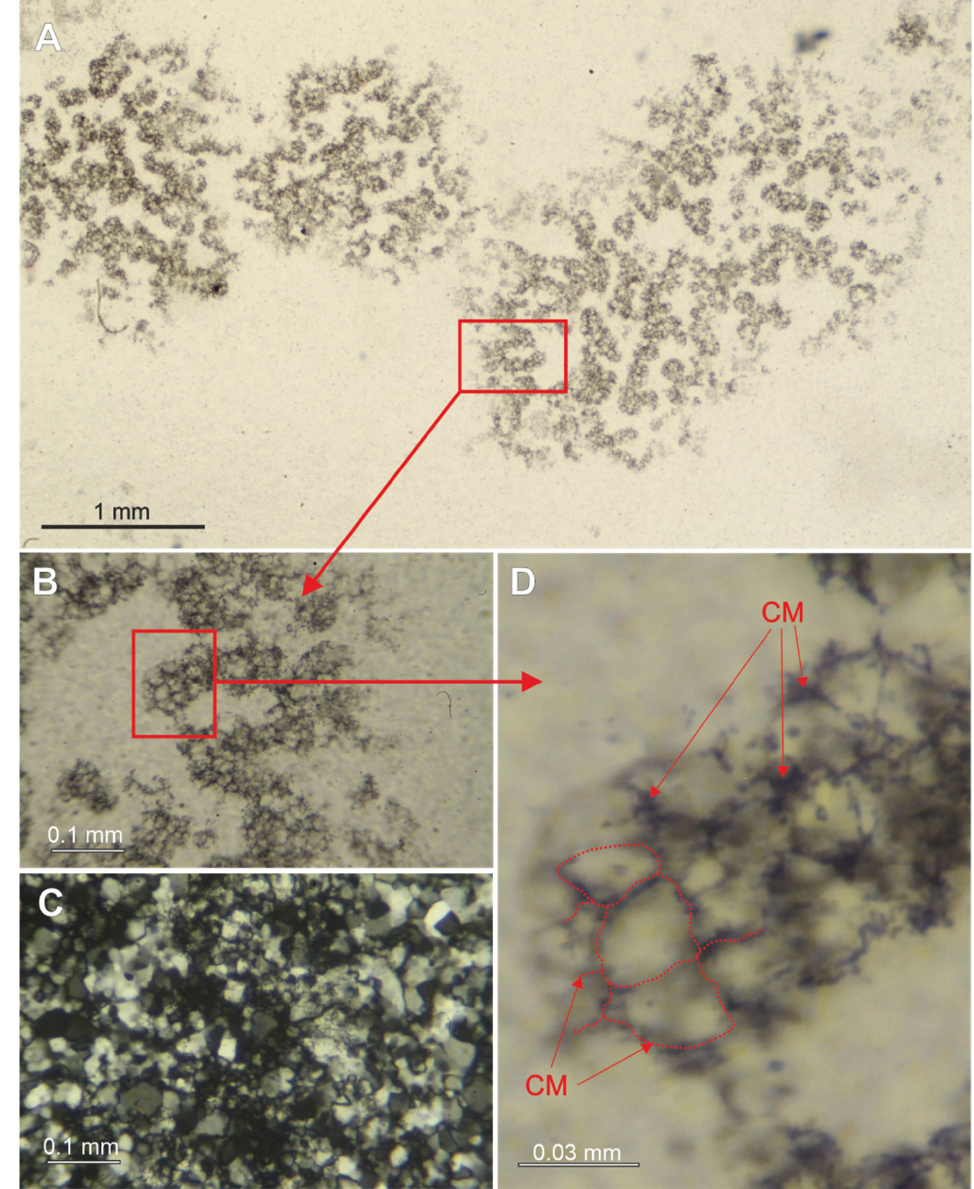
Figure 5. Microphotographs of moss agates (Figure 3G): accumulations of disseminated carbonaceous matter (CM) within the chalcedony matrix in transmitted light ( A ), enlarged fragment from the dark rounded segregation (as indicated in ( A )) in transmitted light ( B ), and the same fragment between crossed nicols ( C ). ( D ) Enlarged fragment of selected area from ( B ), red dotted lines and arrows shows CM distribution between chalcedony grains.